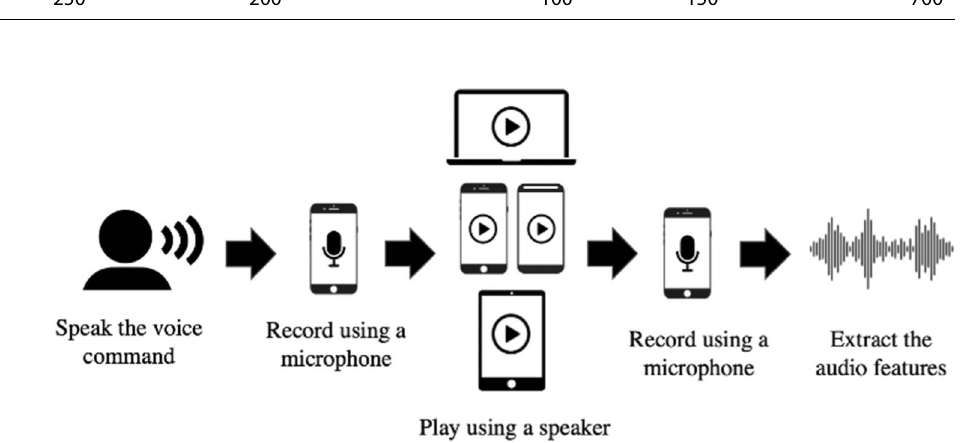
Table 2 Devices used to play back the recordings and the distribution of samples collected by each device Device iPhone 12 Number of data recorded